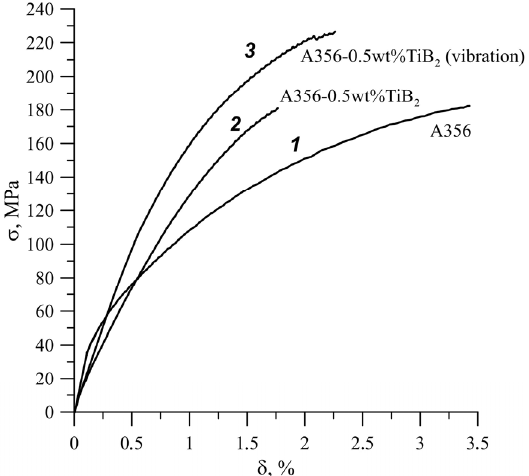
Figure 4. Mechanical properties of А 356 aluminum alloy and aluminum-based composite alloys, before and after vibration treatment. (1) А 356 alloy; (2) А 356 alloy after vibration treatment; and (3) А 356 + 0.5 wt% TiB 2 after vibration